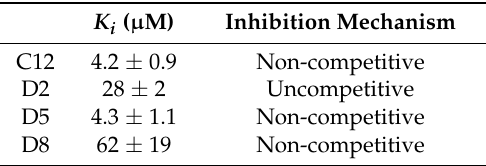
Table 4. Inhibition constants and mechanisms for the best-performing inhibitors of the diaphorase activity of Xcc FPR. Values calculated by globally fitting the experimental data to the corresponding Lineweaver–Burk inhibition model. Measurements were carried out at 25 ◦ C, in 50 mM Tris/HCl, 2% DMSO, pH 8.0 ( n = 3, means ±